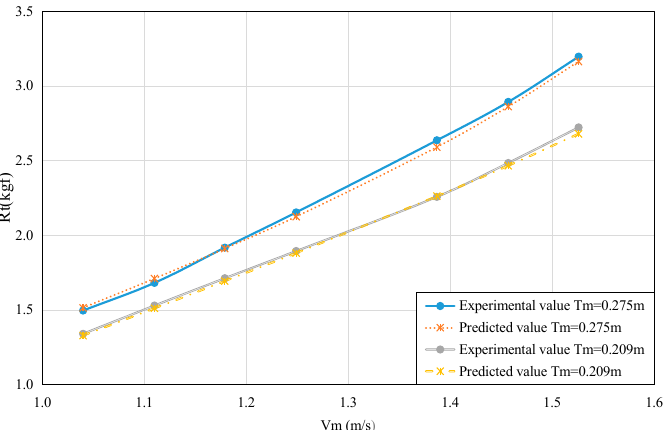
Figure 11. The curves of R t versus V m at the drafts of 0.209 m and 0.275 m by the best performing model. Table 11. The experimental values and predicted values of test set by the best performing model. For the extrapolation prediction, the resistance coefficient C t obtained by the SVM prediction model is converted to the corresponding ship resistance R t . The performances of the SVM model and the RBFNN model are shown in Figures 12 and 13.